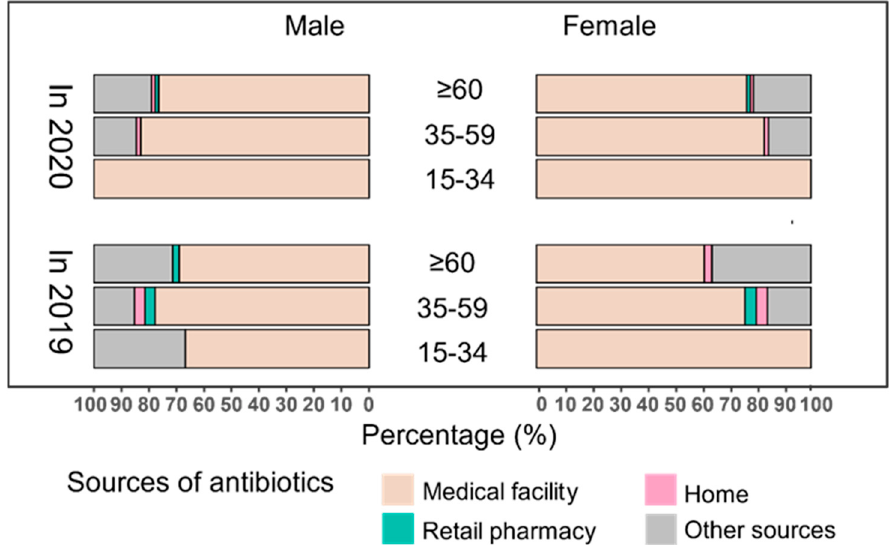
Figure 1. The proportion of different categories of antibiotics in medicine diaries among the study population in Eastern China, 2019–2020. (Data shown are unstandardized percentages. The pro- portion of cephalosporins are different between 2019 and 2020 ( p = 0.011).).